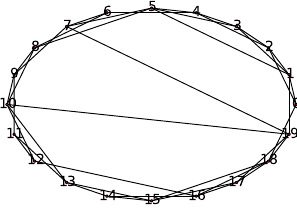
Figure 10. Small-world network